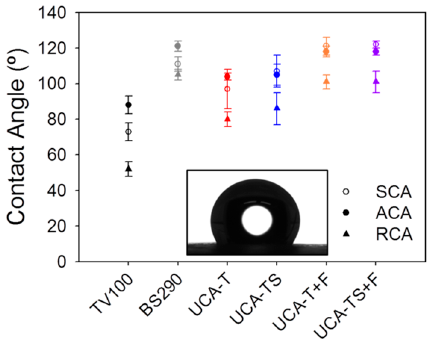
Figure 7. Static contact angle (CA) values and their corresponding advancing and receding CAs for the treated stones. Inset image corresponds to a droplet on stone with TS + F treatment.